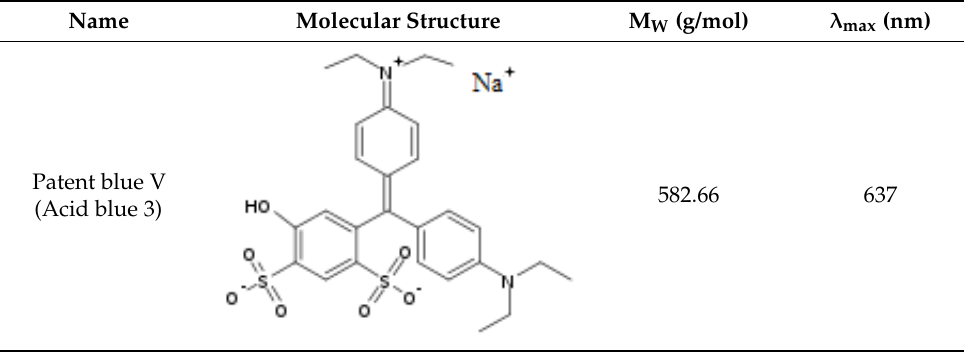
Table 1. Molecular structure and physical characteristics of patent blue V.